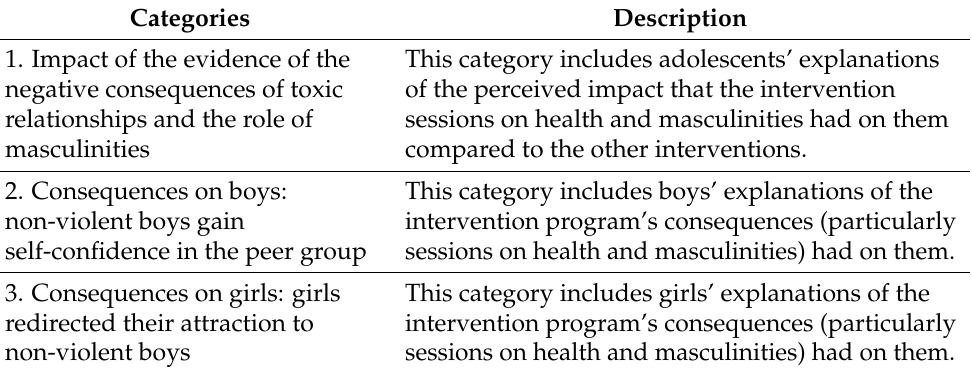
Table 1. Categories of